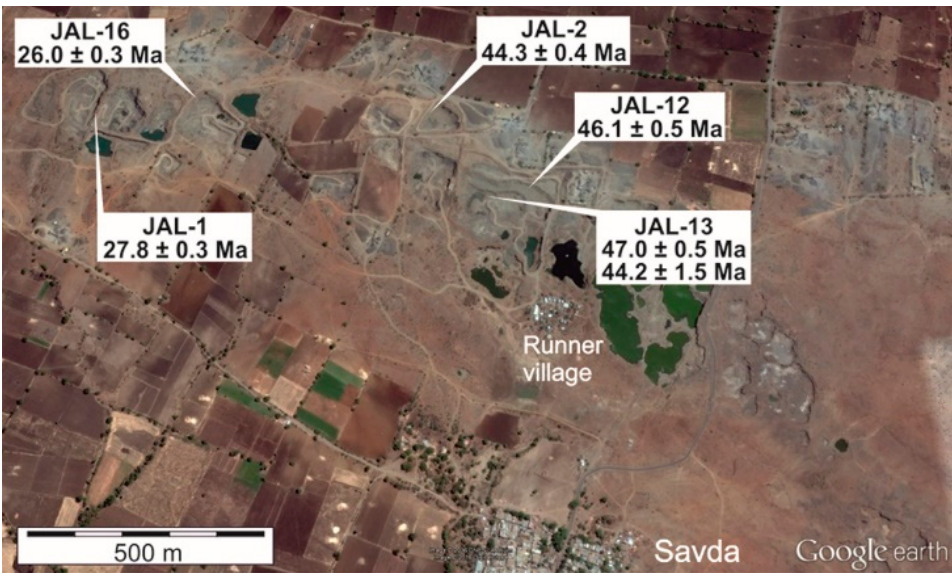
Figure 15. Locations of samples in the Savda quarries and determined Rb ‐ Sr ages of apophyllite; samples JAL ‐ 1 and JAL ‐ 16B were collected in the western part of the quarries and yield ages of about 27 Ma, whereas JAL ‐ 2, JAL ‐ 12, and JAL ‐ 13 from the eastern part provide an age of about 45 Ma.